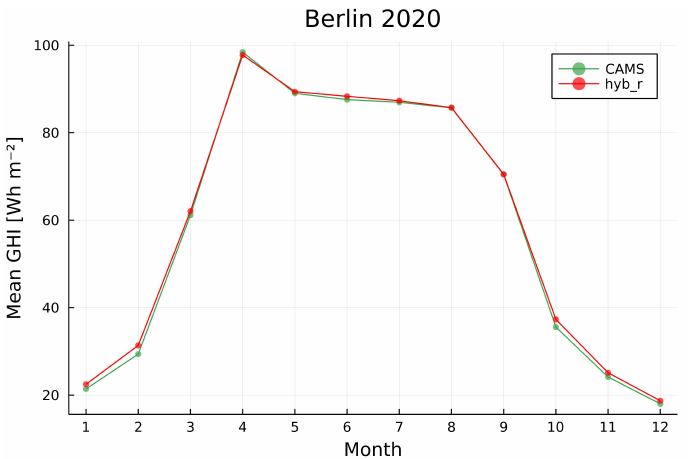
Figure 14. Comparison of actual monthly GHI by CAMS (green) and predicted with a lead time of 15 min by the hybrid approach based on RMSE (red) for Berlin in